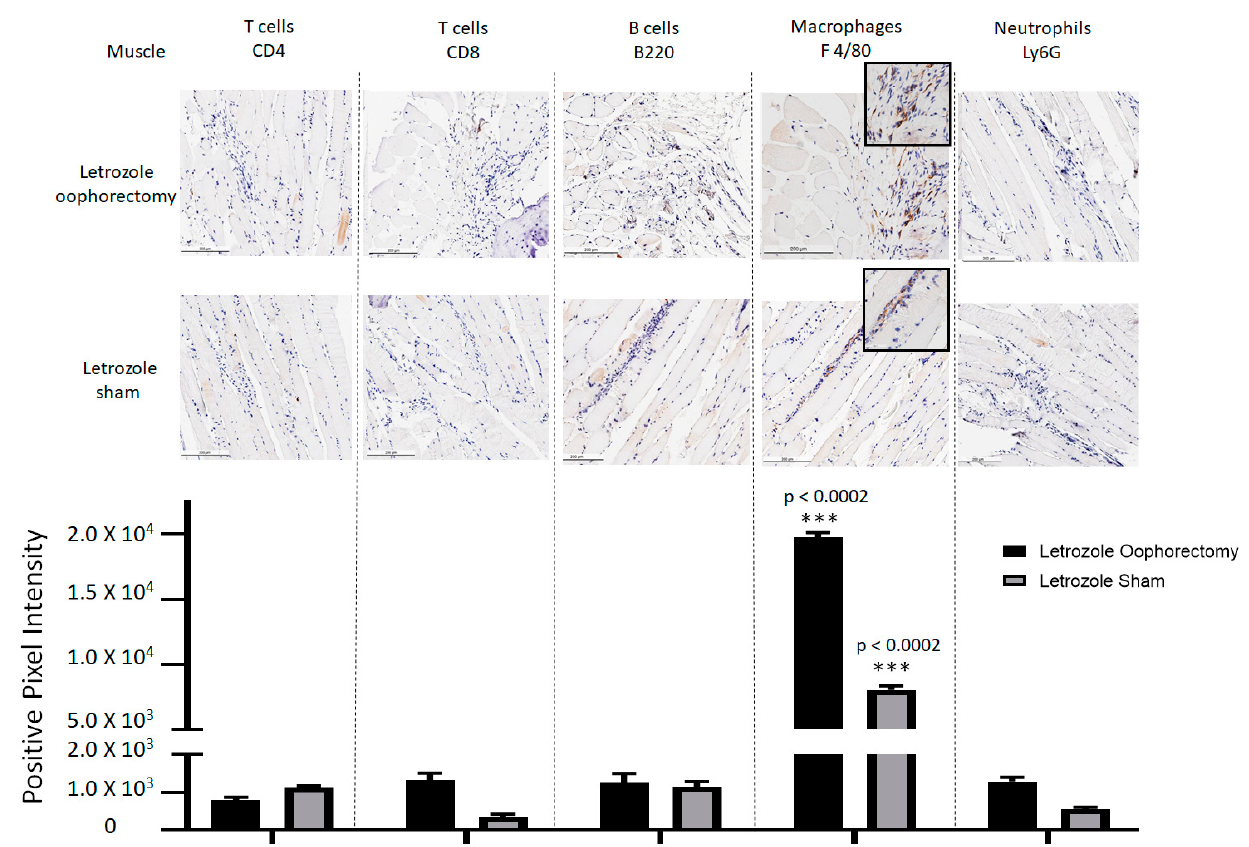
Figure 6. Macrophage-predominant inflammation of muscle tissue detected with AIIA induced by aromatase inhibitor treatment. As outlined in the Materials and Methods Section, AIIA was induced in mice by administration of daily letrozole injections subsequent to oophorectomy or control (sham) surgery. Histopathology of muscle tissue was evaluated via IHC staining of CD4+ T cells, CD8+ T cells, B220+ B cells, F 4/80+ macrophages, and Ly6G+ neutrophils to characterize immune cell subtypes. Data analysis was performed using two-way ANOVA for group-wise comparisons relative to each IHC stain. Two-way ANOVA with Tukey’s correction for multiple comparisons was performed to evaluate the statistical changes between IHC cell stain/subtype. Values shown are the mean ± SEM, with indicated p values relative to other immune cell subtypes. *** p ≤ 0.001.All values of p ≤ 0.05 were considered statistically significant relative to each stain individually.